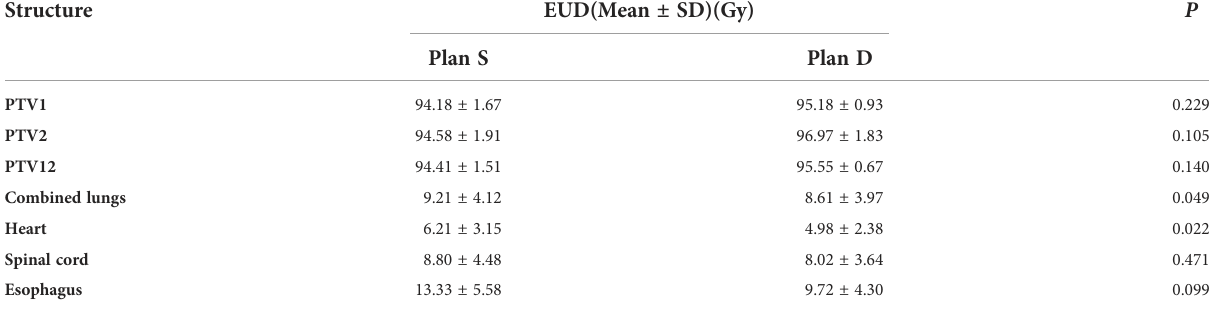
TABLE 5 Comparisons of equivalent uniform dose (EUD) for the PTVs and OARs.